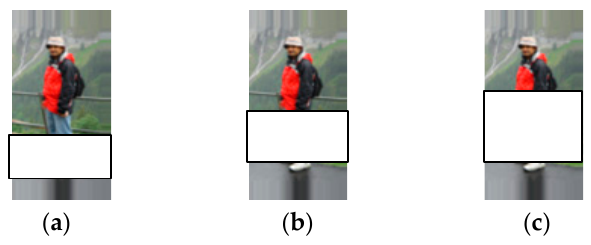
Figure 6. Examples of pedestrian images with random block occlusion. ( a ) 20% block occlusion; ( b ) 30% block occlusion; ( c ) 40% block occlusion.